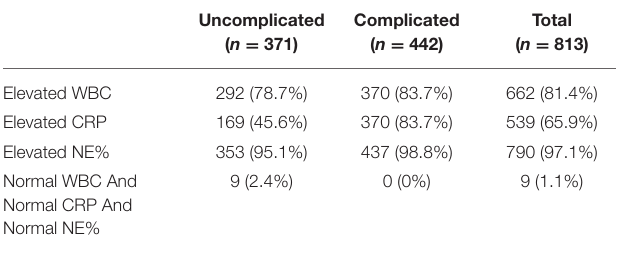
TABLE 3 | Sensitivity of elevation of WBCC, elevation of CRP, elevation NE%, and meanwhile normal of three inflammatory marker (WBCC, CRP, and NE%) according to surgical and histopathologic findings.